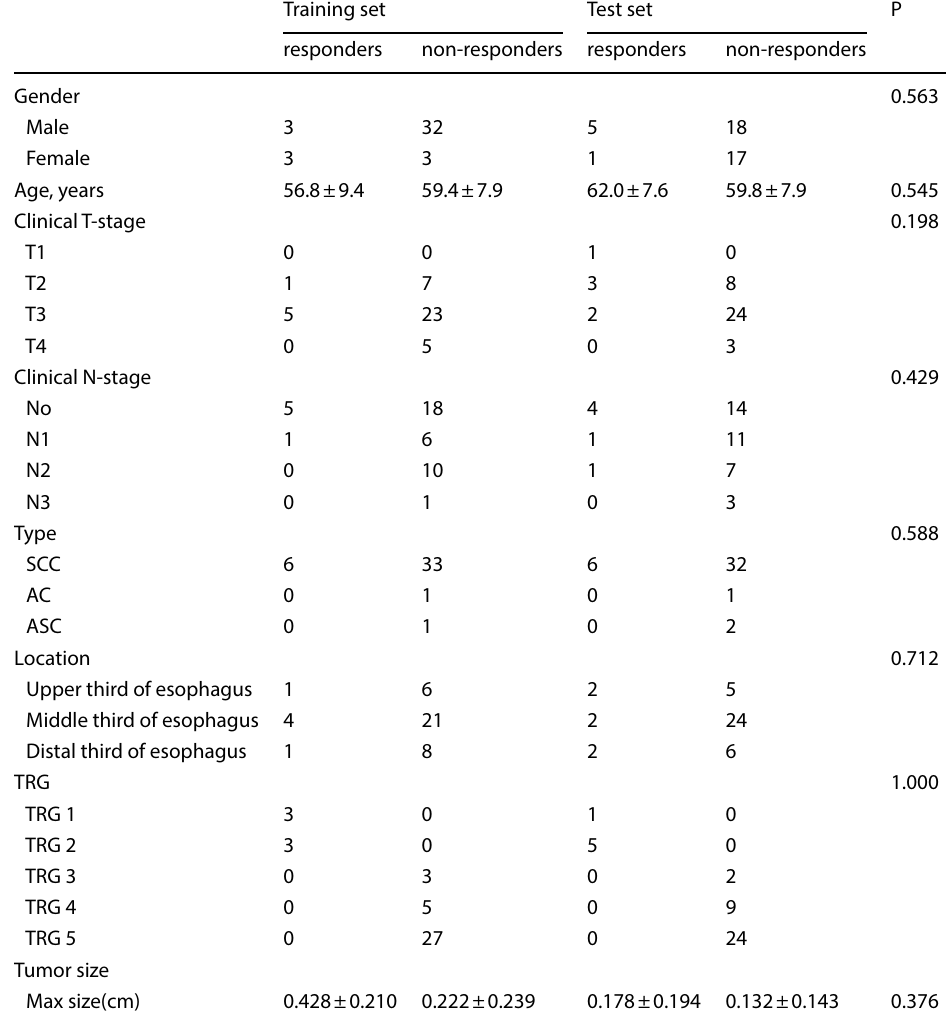
Table 1 Patient and treatment-related characteristics with pre-nCT EC in the training set and test set (n =